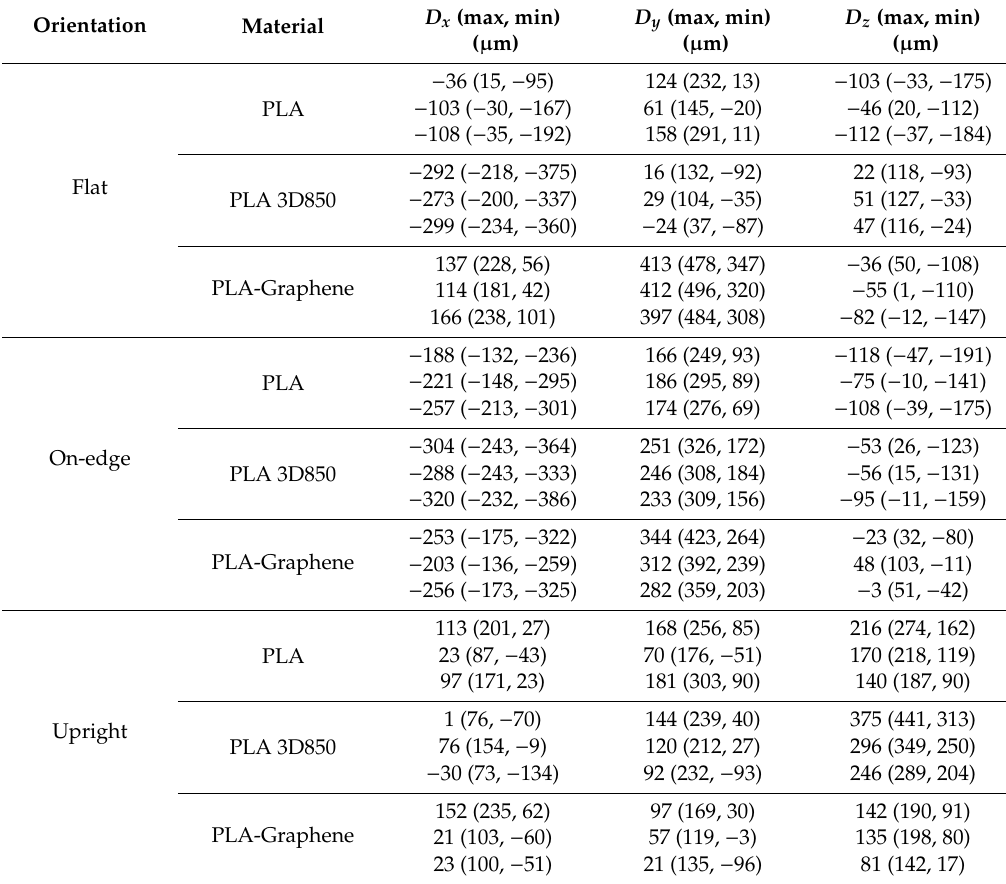
Table 6. Average dimensional accuracy results of PLA, PLA 3D850 and PLA-Graphene samples as a function of build orientation and the type of material. The results of three samples of each set are shown for comparative purposes. Maximum and minimum dimensional deviation of each sample are depicted in